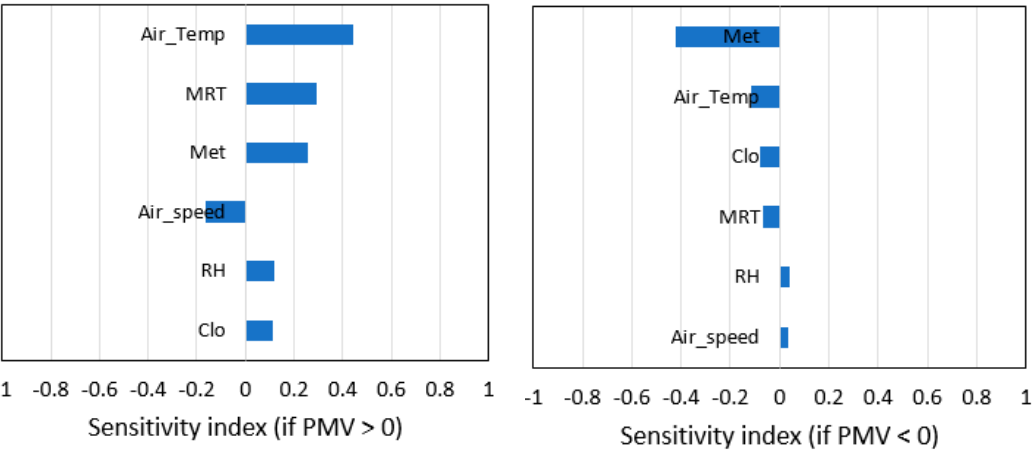
Figure 7. Sensitivity analysis results to determine the impact of factors affecting thermal comfort.